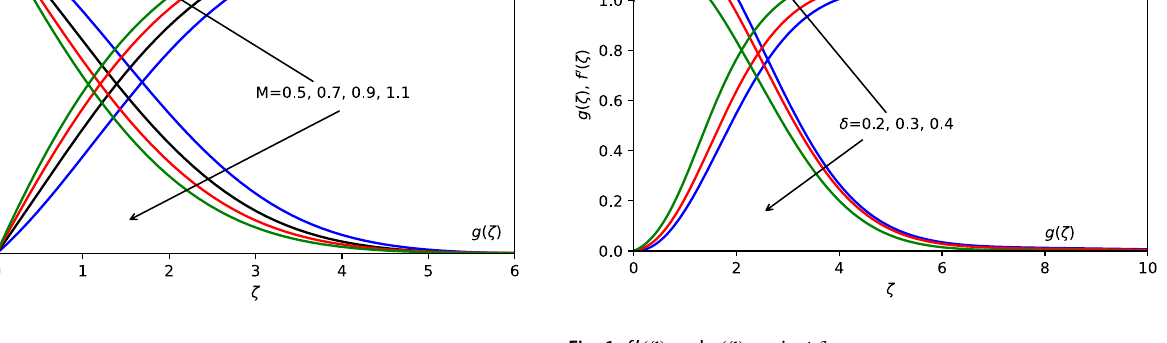
Fig. 6 f � ( 𝜁 ) and g ( 𝜁 ) against 𝛿